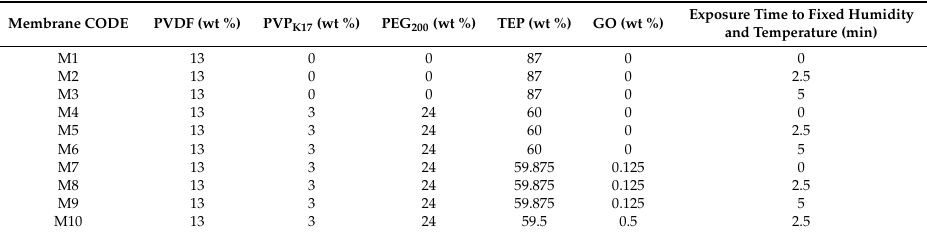
Table 2. Dope solution components of the prepared membranes.